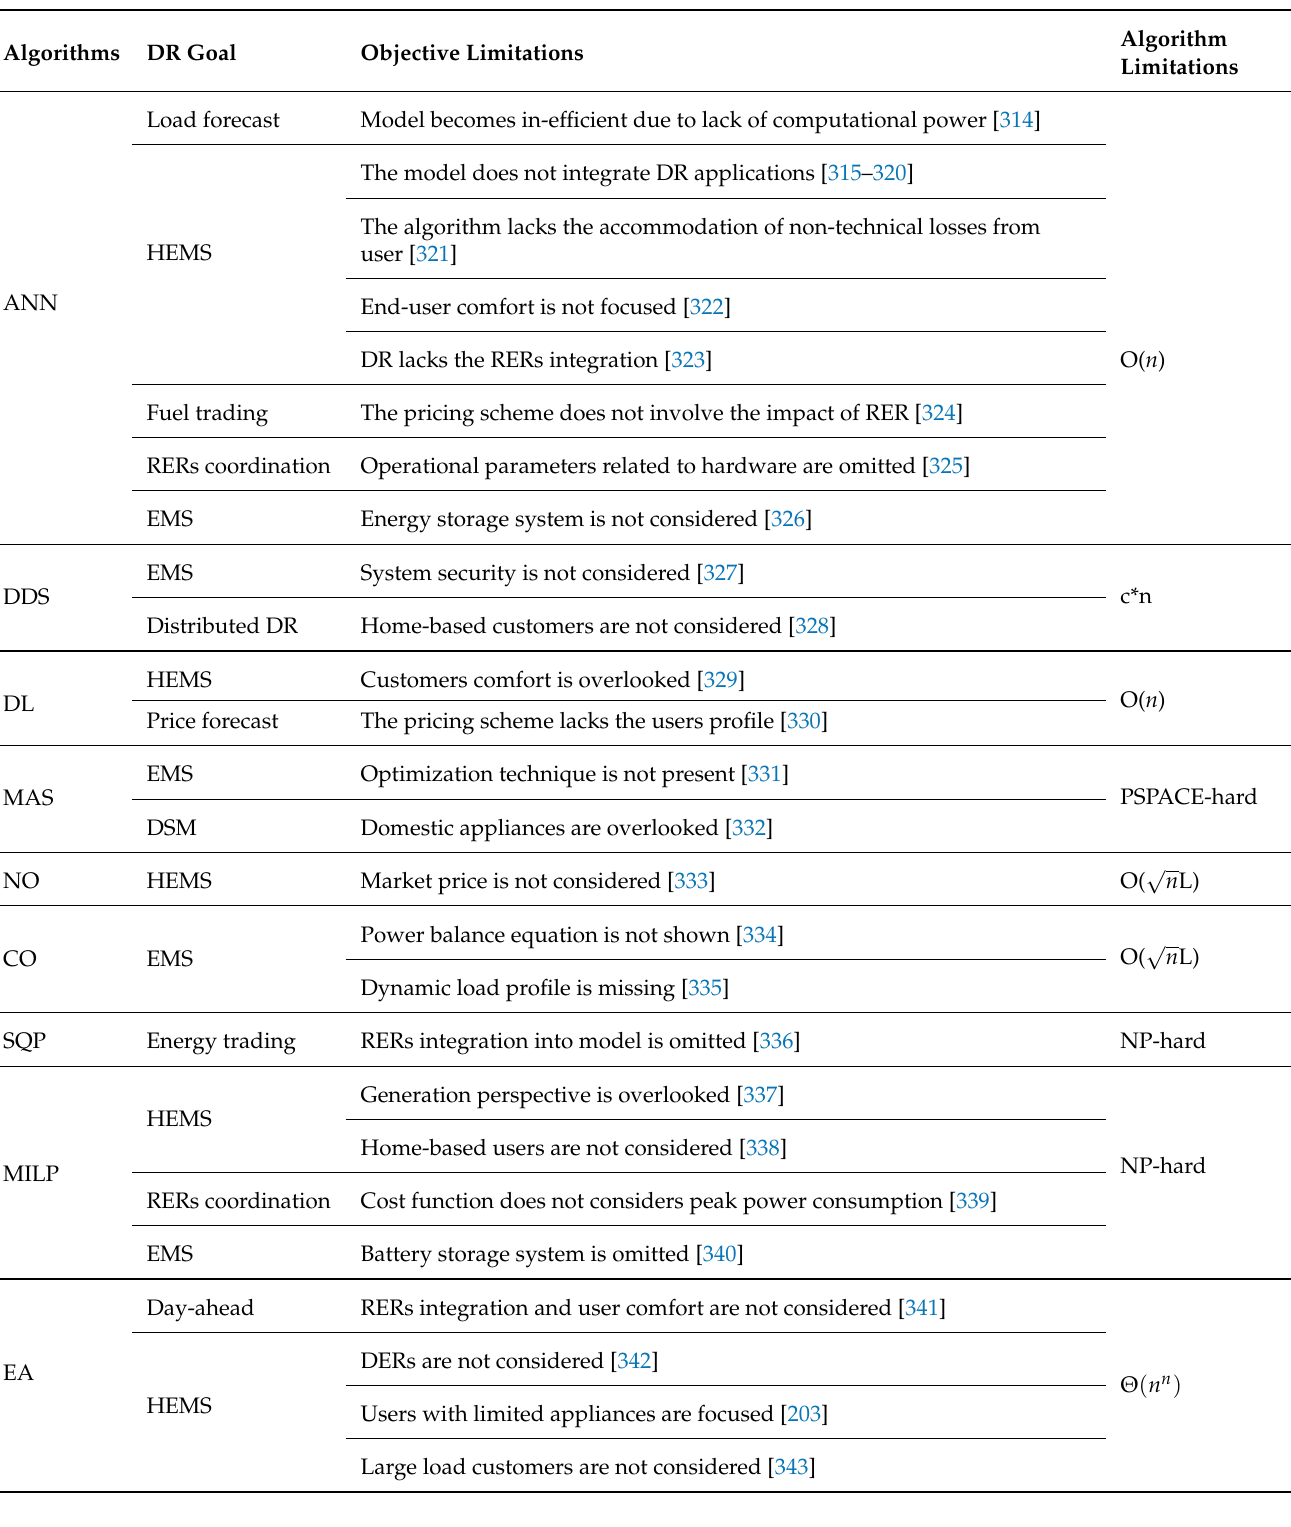
Table 5. Goal-oriented DR based on intelligent